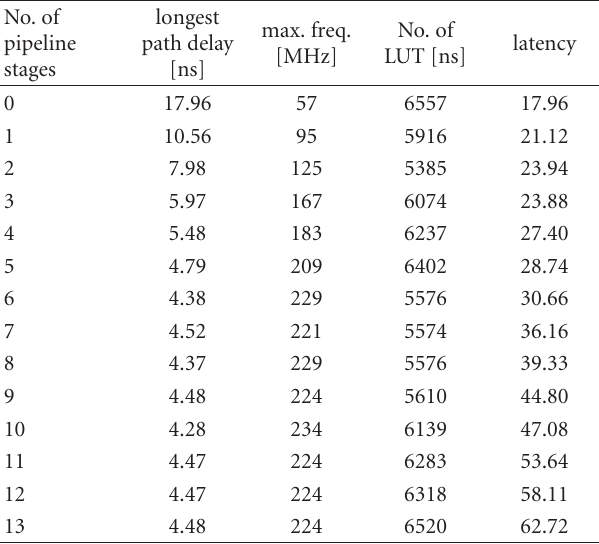
Figure 13: Latency and delay (Post-Place & Route Results) for decimal multiplier, p = 16 digits, Table 2: Post-place & route results for decimal fixed-point multiplier with CPA output.